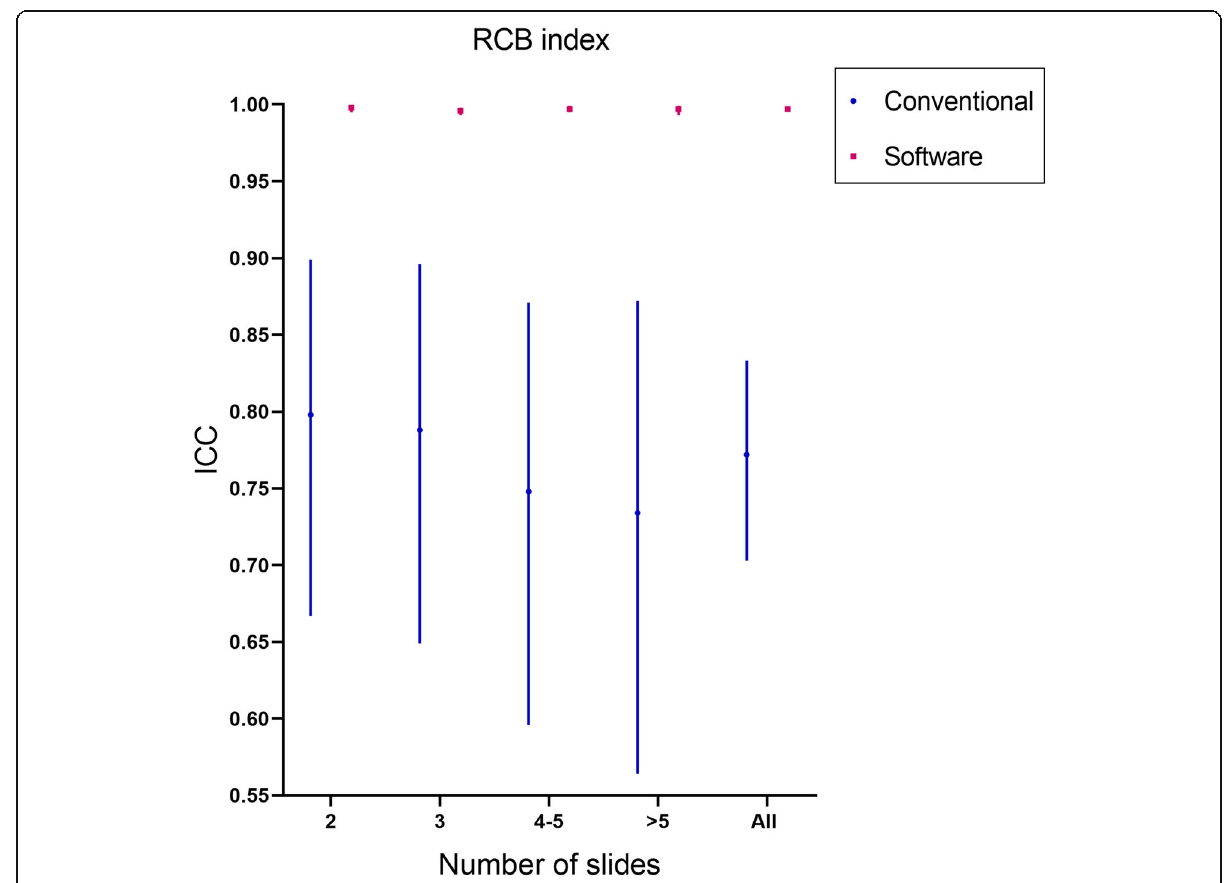
Fig. 7 Comparison of RCB index consistency between the software-assisted method and conventional method by five